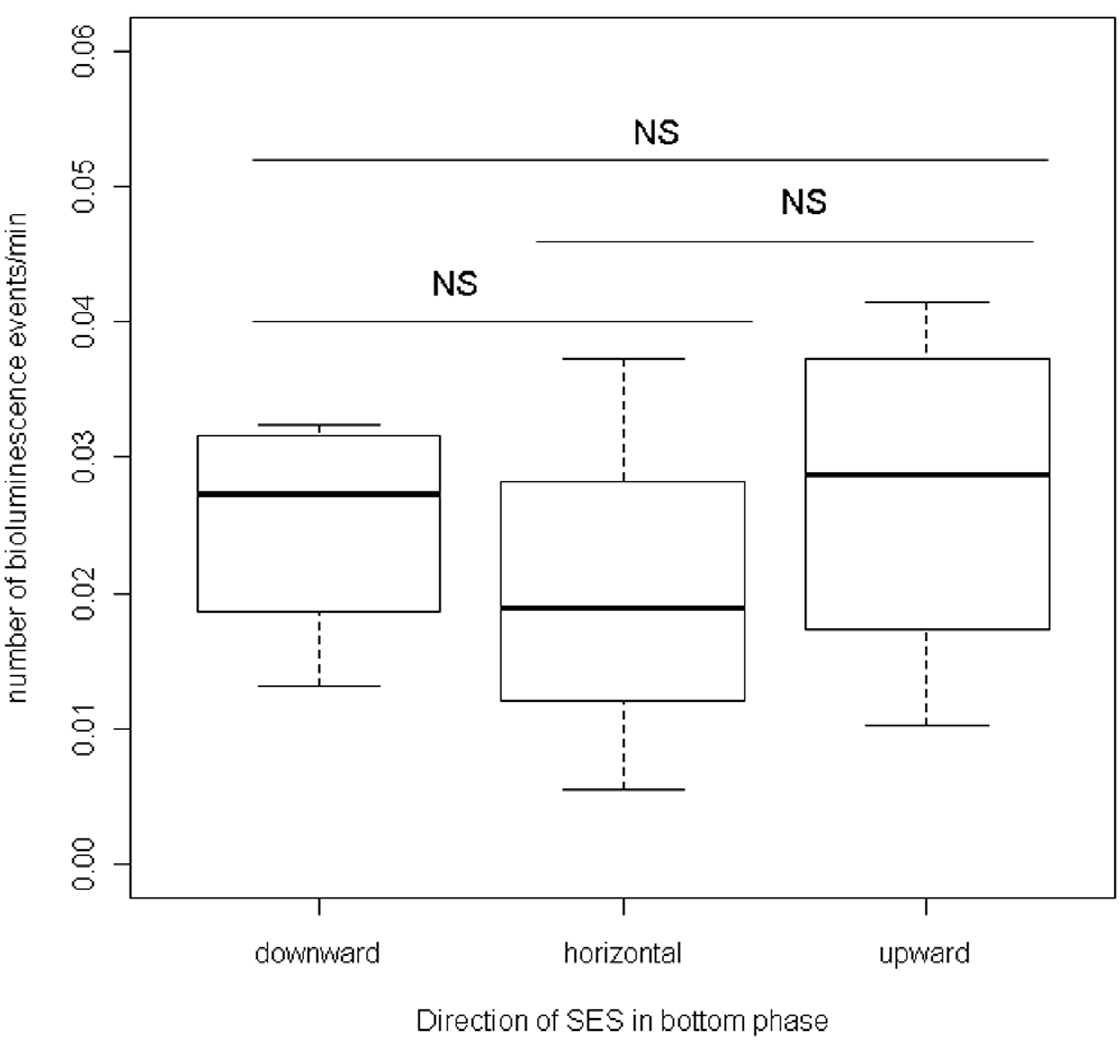
Figure 8. Bioluminescence and predator movement into the bottom phase. This graph represents the number of bioluminescence events encountered in the bottom phase of the dive in a downward, horizontal or upward movement.